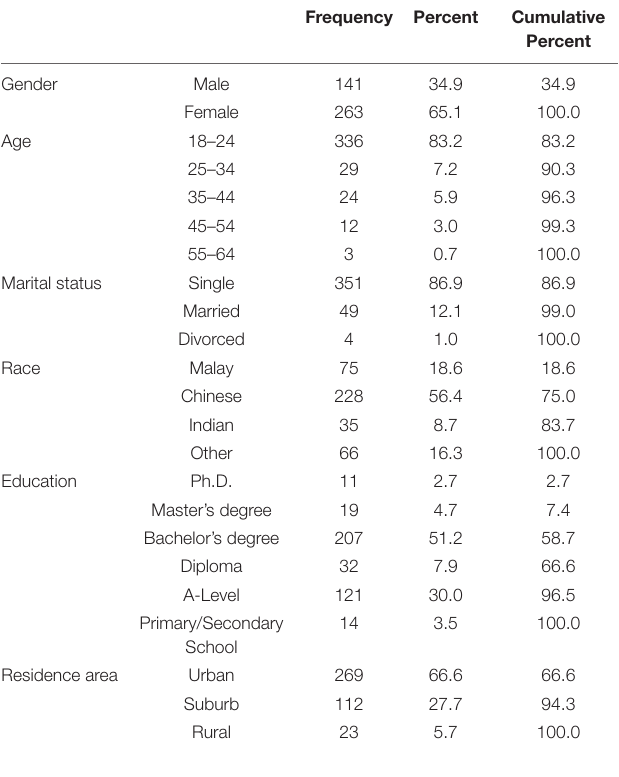
TABLE 1 | The demographic information of the